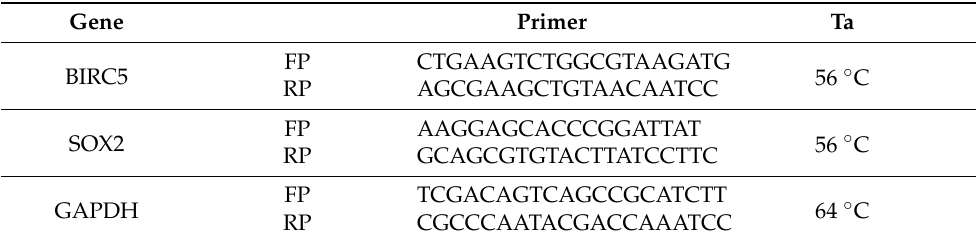
Table 1. The forward and reverse primers used in